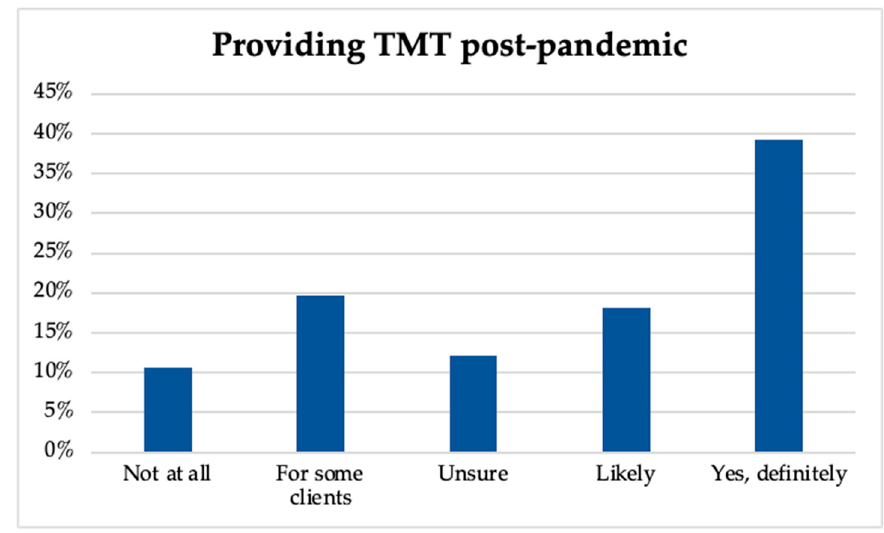
Figure 3. Providing TMT post-pandemic.